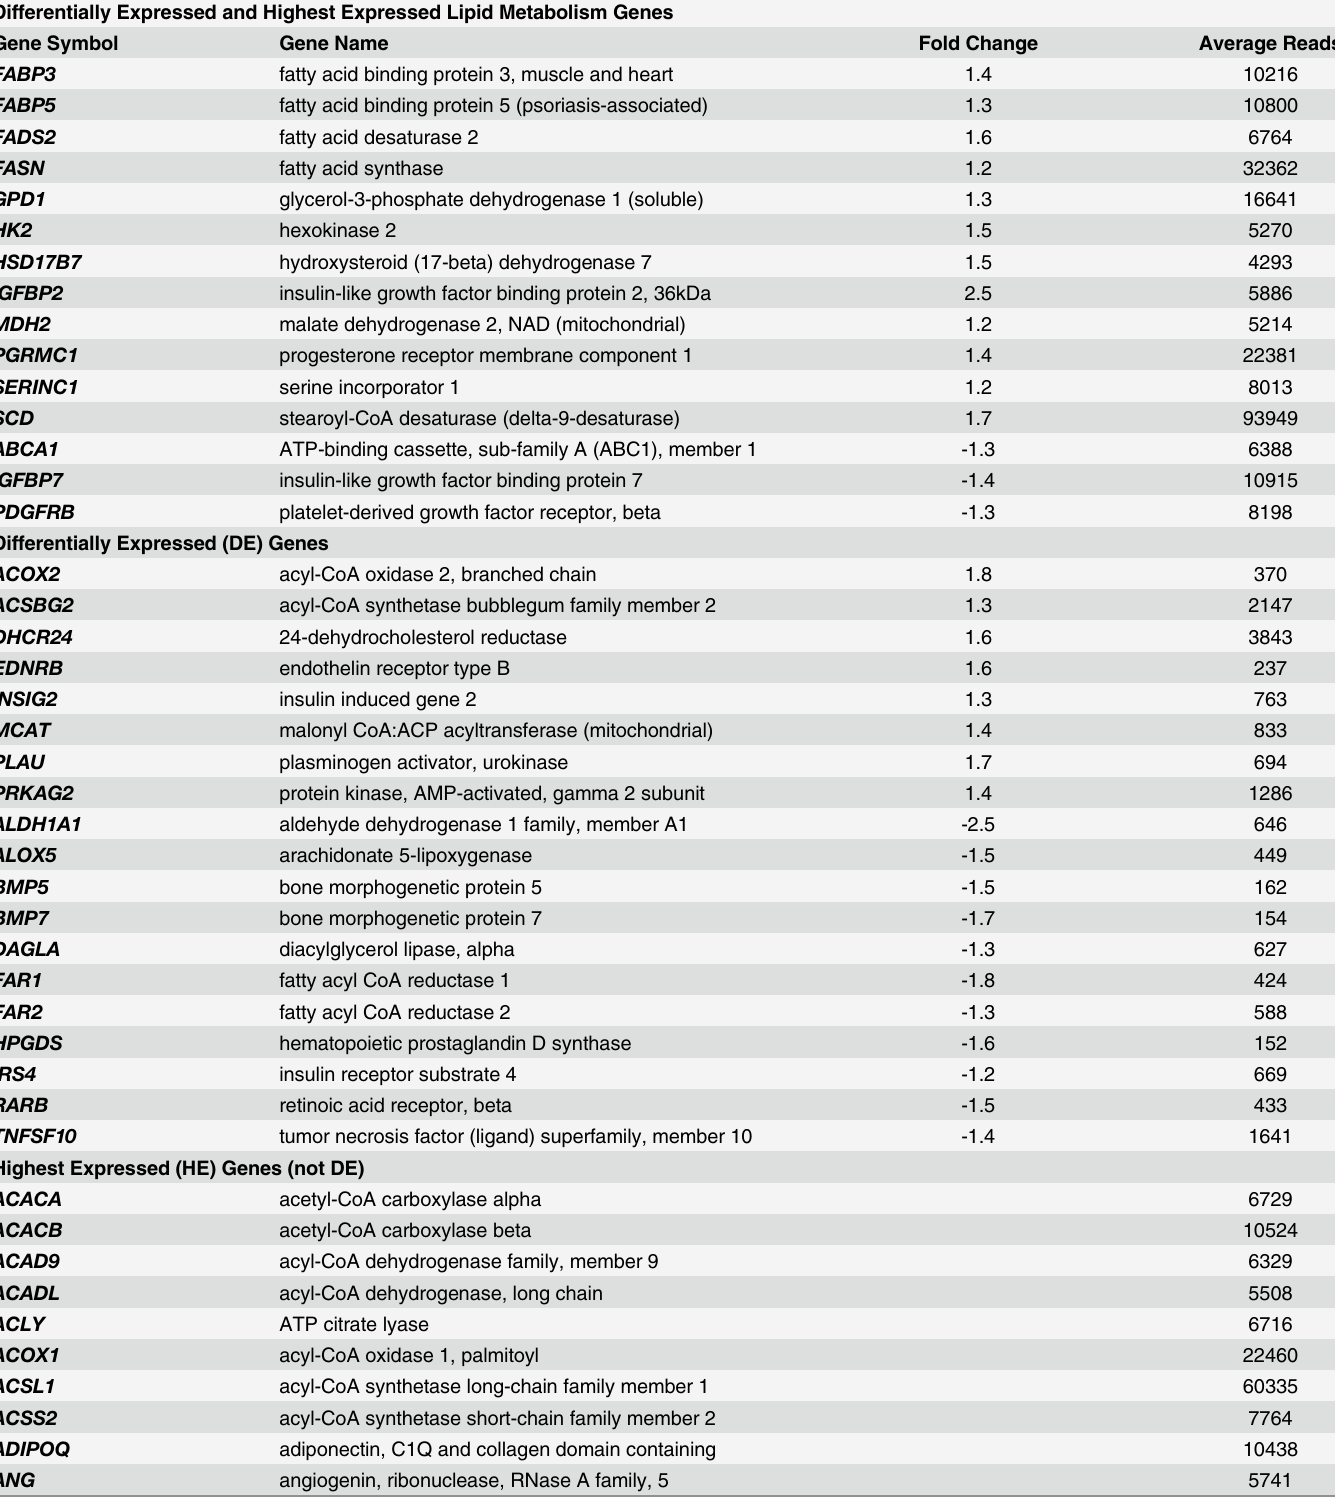
Table 4. Functional genes identified by RNA-Seq analysis of abdominal fat in FL and LL cockerels at 7 wk. Differentially Expressed and Highest Expressed Lipid Metabolism Genes Gene Symbol Gene Name Fold Change Average Reads FABP3 fatty acid binding protein 3, muscle and heart